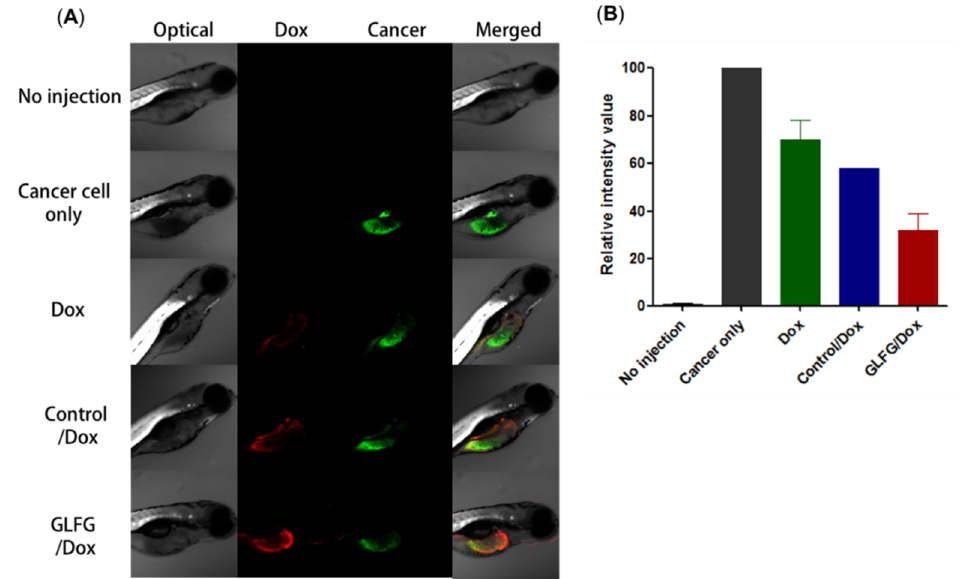
Figure 6. Anticancer assay in a Zebrafish model transplanted with labeled Hep G2 cells. Free Dox, control/Dox, and GLFG/Dox liposomes, each with 5μM of Dox, were used for treatment for 48 h, and ( A ) Dox (red) and labeled Hep G2 cells (green) were imaged using a confocal microscopy. ( B ) Quantification the fluorescence intensity of the cancer cells, (No injection (n = 3), cancer cells only (n = 1, two fish were dead), Dox (n = 3), control/Dox (n = 2, one fish was dead), GLFG/Dox (n = 3)) .